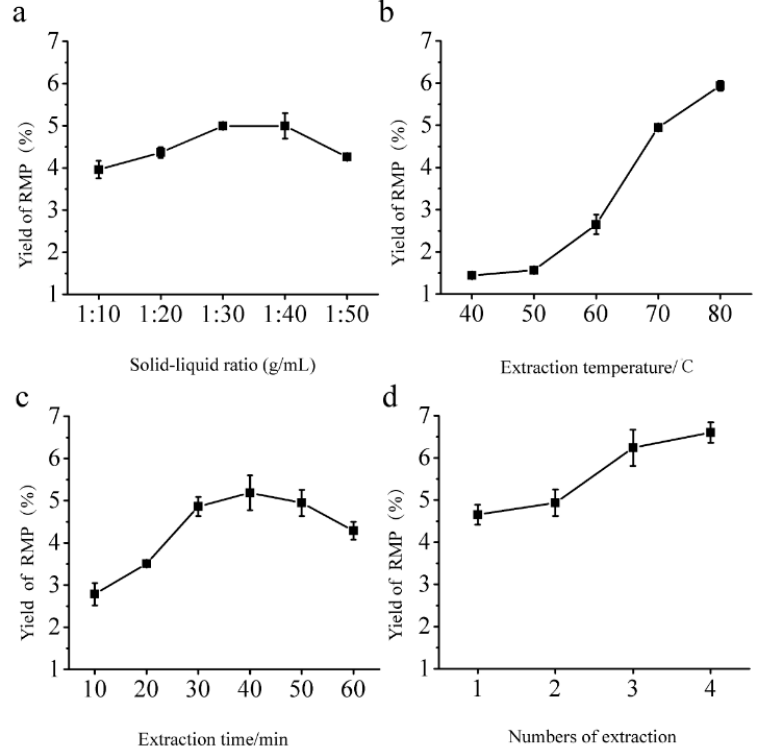
Figure 1. Relationships between ( a ) solid–liquid ratio, ( b ) extraction temperature, ( c ) extraction time, and ( d ) number of extractions and R. mori polysaccharide (RMP) yield in single-factor experiments.